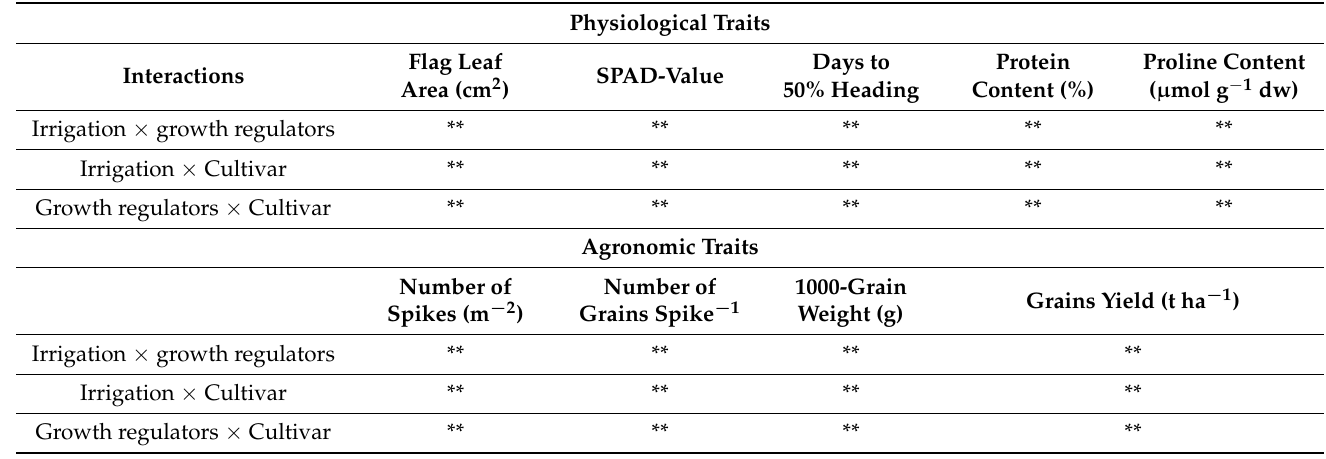
Table 4. Significant of three first-order interactions of combinations between irrigation intervals, growth regulators and wheat cultivars on physiological and agronomic traits of wheat in (combined two seasons).